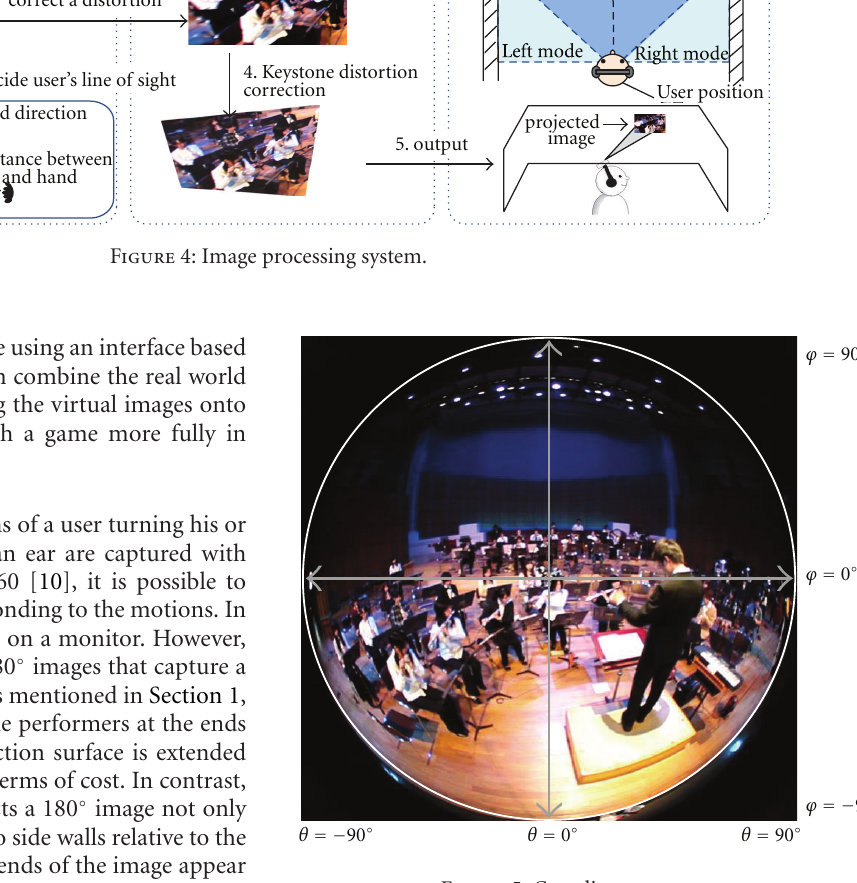
Figure 5: Coordinates on a